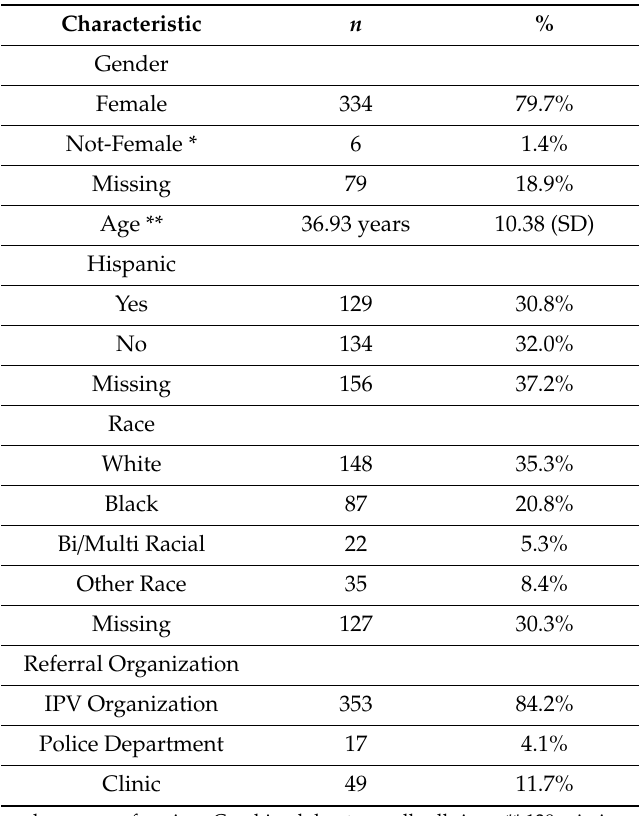
Table 2. Health advocacy client demographics ( n =